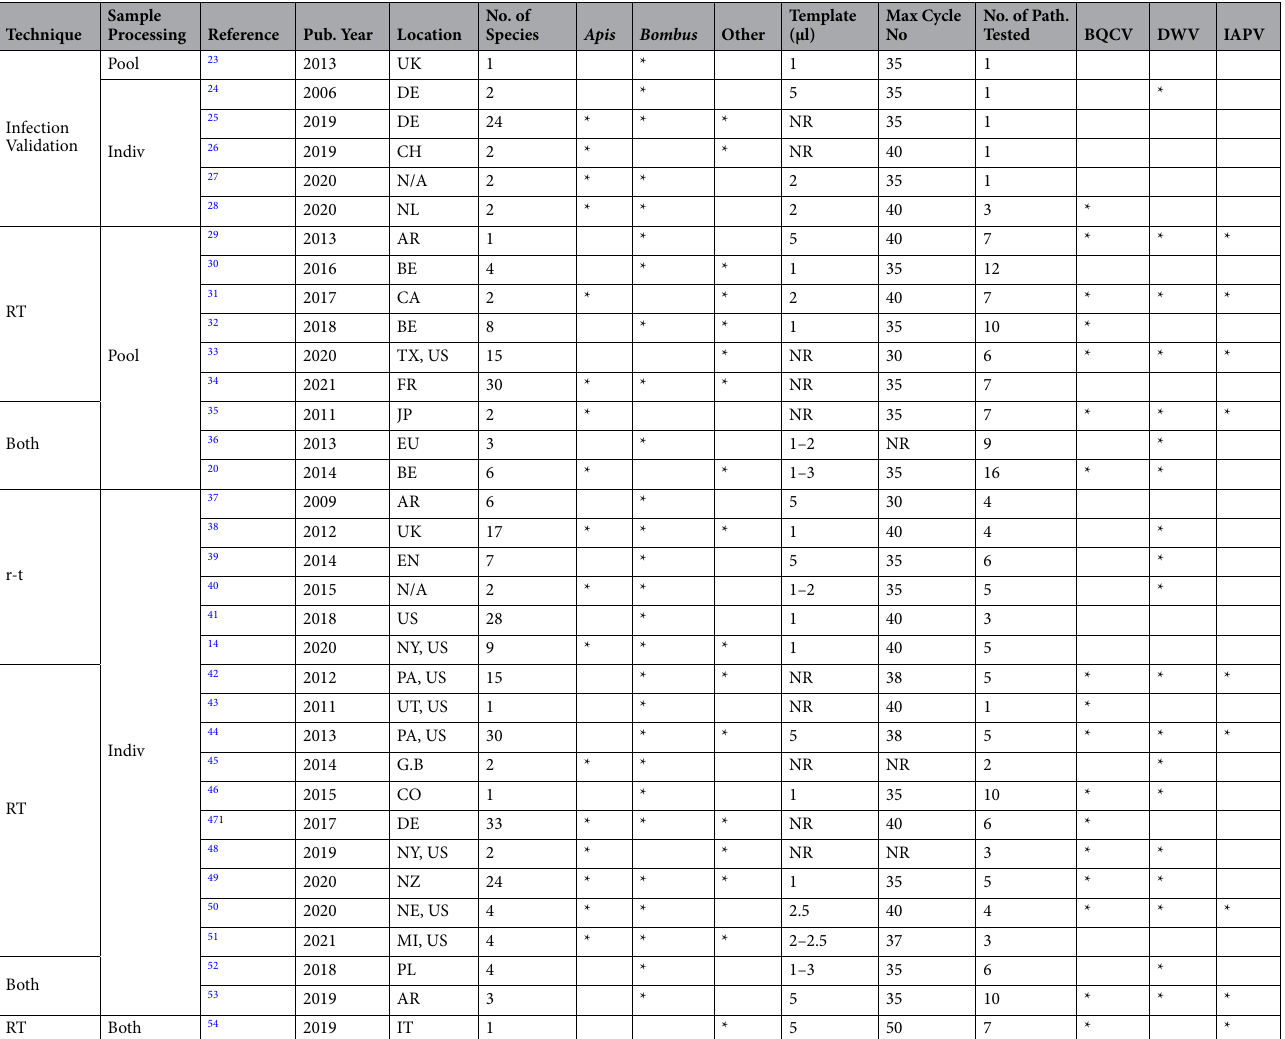
Table 1. A summary of previous screenings of bees for interspecific pathogen detection. A two-letter code is used for each country, with a two-letter state code also included for US projects. The total number of bee species tested is shown, followed by if certain common species were included. Similarly, the total number of pathogens tested is shown, followed by if certain commonly tested for pathogens were included. This table shows papers that tested for infection validation or used ‘traditional’ PCR techniques (real time PCR [r-t], reverse transcription [RT] PCR, or Both r-t and RT) only. When a piece of information was not reported, it is shown as NR in the table. Max cycle number refers to the cycle number used during PCR analysis. 1 This paper used capillary electrophoresis to score their